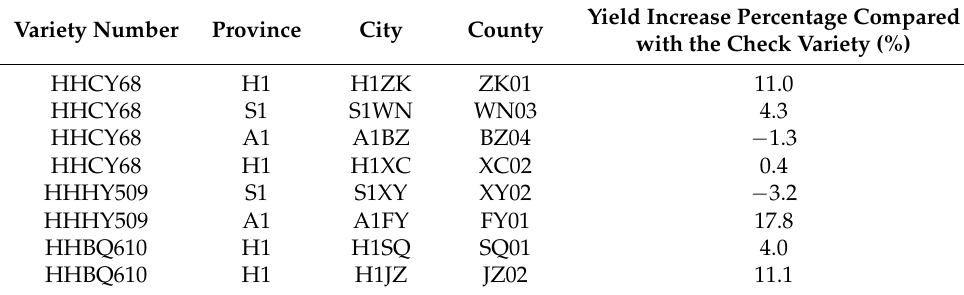
Yield Increase Percentage